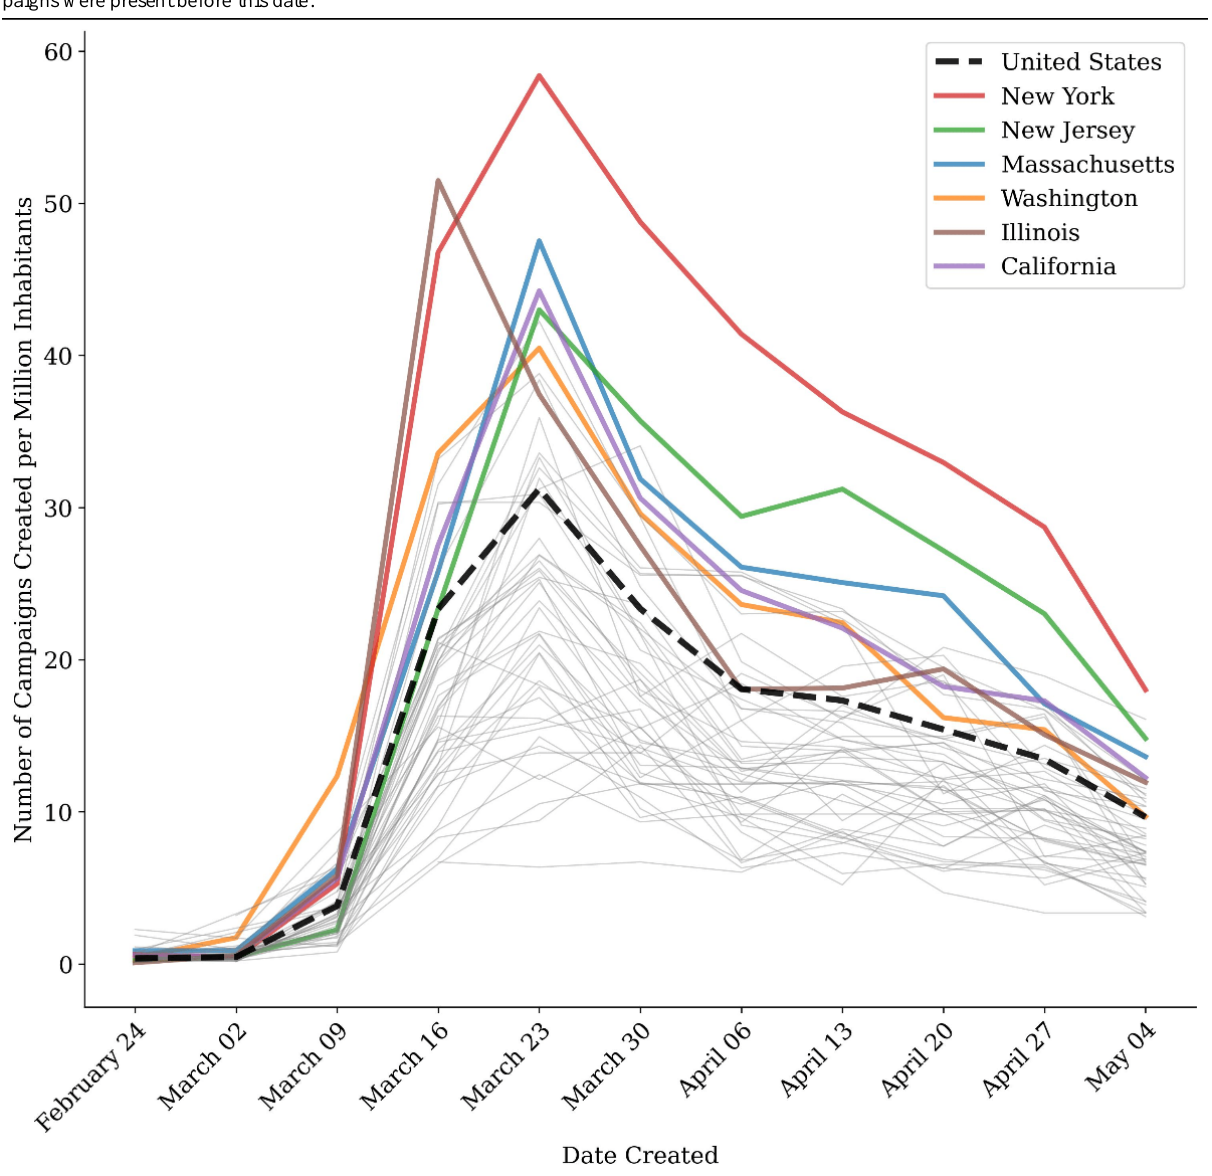
Figure 3. COVID-19–related GoFundMe campaigns per million by week by state. All states are shown, but only the top 6 states for total COVID-19 cases per million are highlighted in color (ordered from most to fewest in the legend). Dates on the x-axis start from February 25, as few COVID-19–related campaigns were present before this